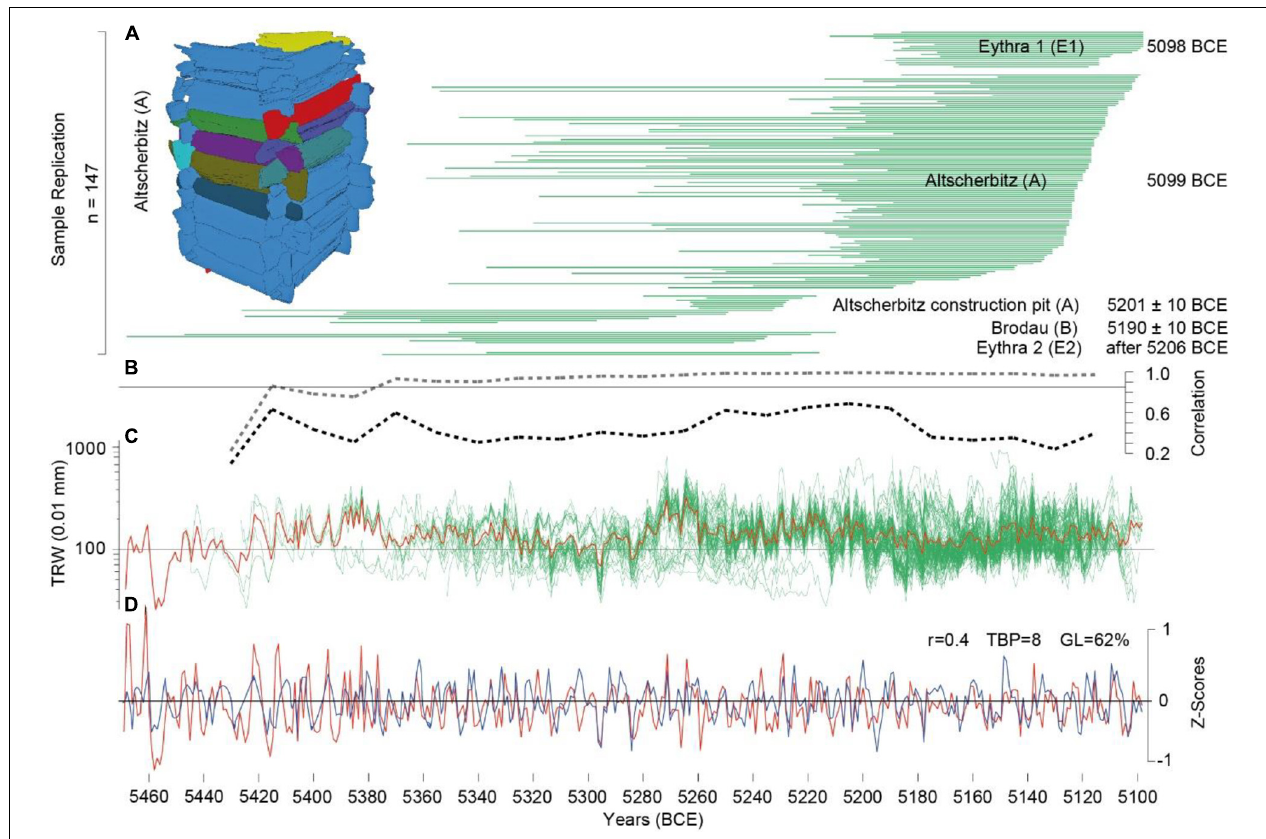
FIGURE 7 | Graphical presentation of dendrochronological results (Tegel et al., 2012). (A) Temporal distribution of the lengths of individual tree-ring sequences, and the youngest felling dates per construction, based on the presence of waney edges (annually precise) or sapwood estimation. The inset shows a 3D reconstruction of a wooden lining displaying each tree using a different color. (B) The common signal in the chronology [so-called Expressed Population Signal (dotted gray line)] and the inter-series correlation (dotted black line) calculated over 50 years lagged by 25 years along all individual samples. (C) Single ring-width measurements (green) and their mean (red). (D) Absolute dating of the new Saxon oak chronology (red) against the reference chronology from the Main River Valley (Becker, 1982) after 10-year low-pass filtering [ r , correlation coefficient; TBP, T -value (Baillie and Pilcher, 1973); GL,